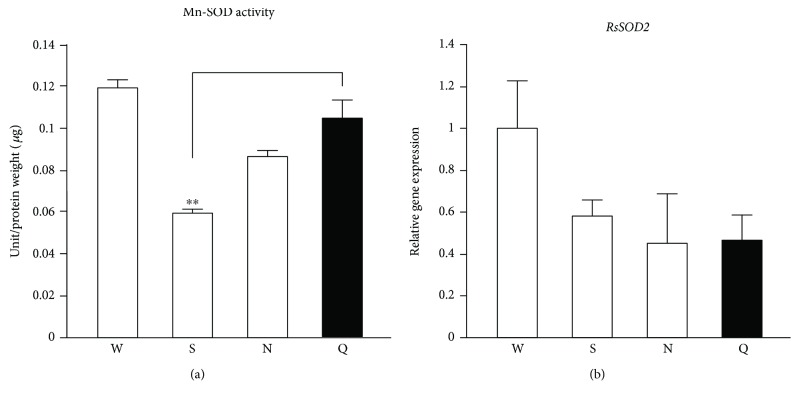
Mn-SOD activity and gene expression in R. speratus queens and nonreproductive individuals. (a) Queens (n = 9) had higher Mn-SOD activity than soldiers (n = 6; P = 0.004) but not workers (n = 6; P = 0.214) or nymphs (n = 6; P = 0.133). (b) Queens (n = 9) did not have higher levels of RsSOD2 gene expression than workers (n = 12; P = 0.224), soldiers (n = 12; P = 0.813), or nymphs (n = 12; P = 0.960). We used pooled samples, as described in Table
S1, for several replications. White and black bars indicate nonreproductive individuals and queens, respectively. Error bars represent SEM. Significance was measured by unpaired t-test followed by Holm's adjustment (∗∗
P < 0.01). W: workers; S: soldiers; N: nymphs; Q: queens.